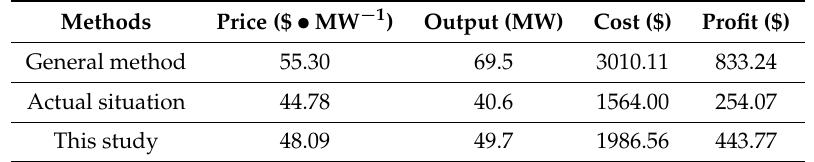
Table 8. Comparison of Bidding Strategies under Different Methods with a Load of 160 MW.